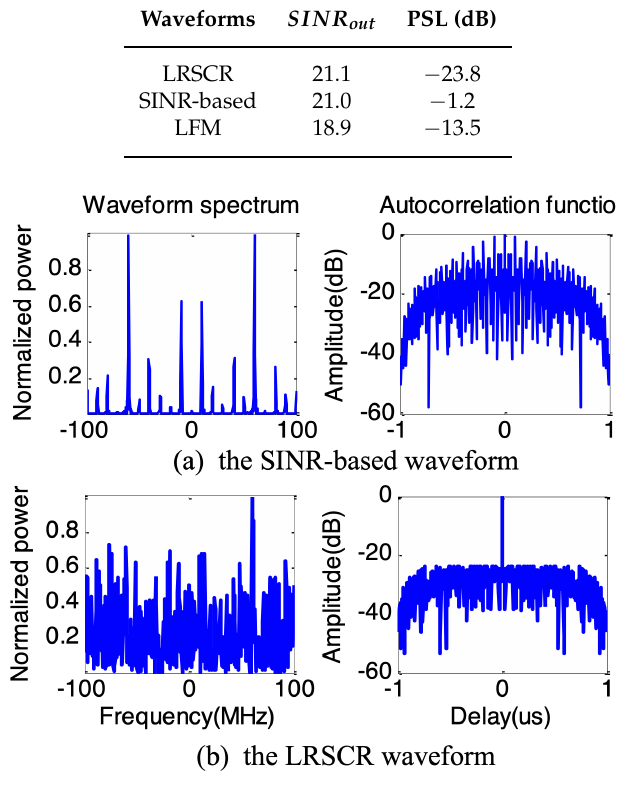
Figure 5. The waveform spectrum and autocorrelation function.